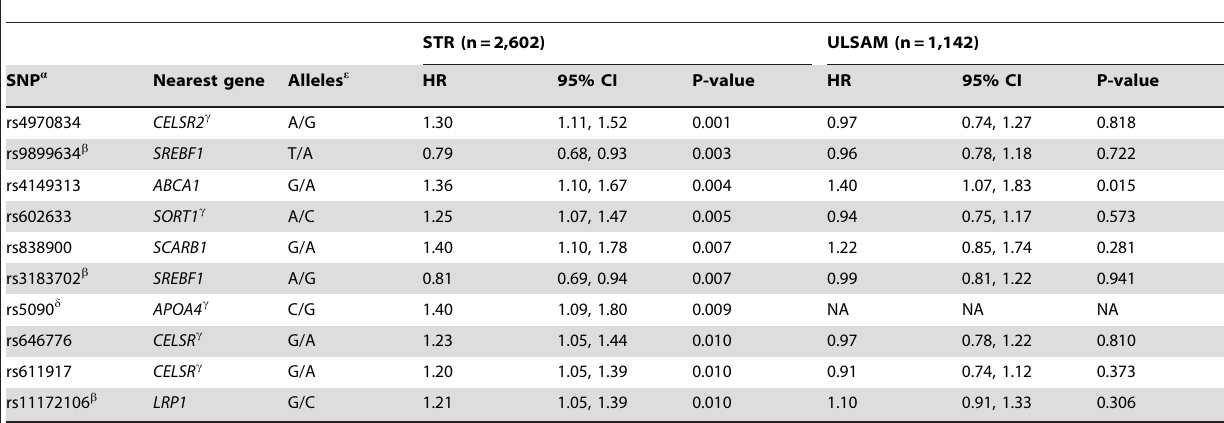
Table 2. Associations of genetic loci with MI in primary and replication